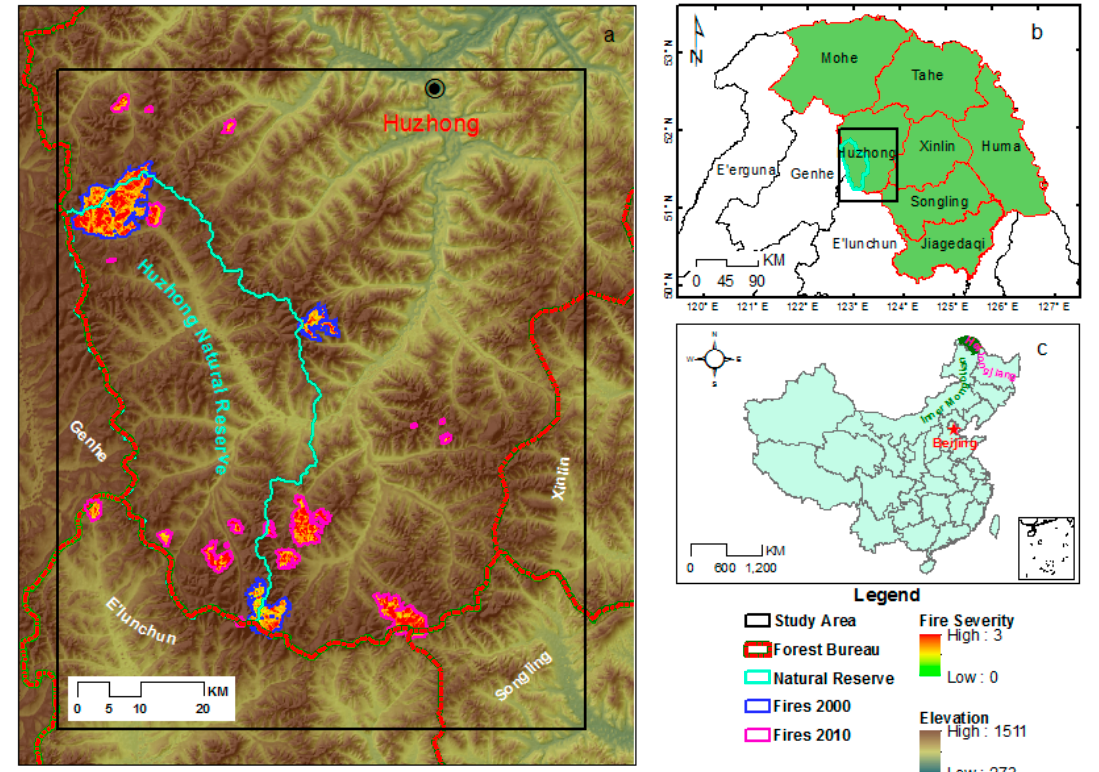
Figure 1. Location of study area ( a ) showing severity of wildfires occurring in 2000 (blue perimeters) and 2010 (pink perimeters). Most of the study area is located in the Huzhong Forestry Bureau ( b ) in the middle of Great Xing’an boreal forests (green patch in b and c) which administratively belongs to Heilongjiang province in northeastern China ( c ). One fire was located in E’lunchun County ( a ), which belongs to the Inner Mongolian part of Great Xing’an boreal forests. Forests within the Huzhong Natural Reserve are primarily natural forests because of a strictly enforced ban on commercial and salvage logging within the reserve since 1958, while forests outside the natural reserve experienced severe cutting since the 1950s. Table 1. Detailed information of 21 fires included in this study.